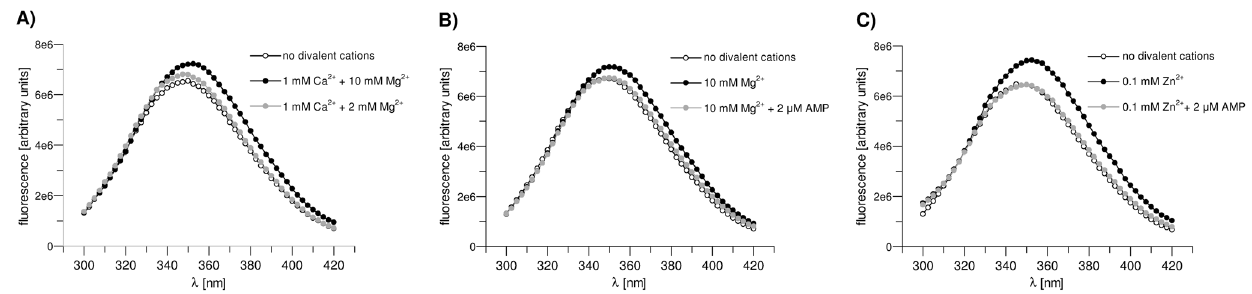
Figure 2. Fluorescence spectra of the Tyr 57 Trp mutant under different ligation conditions. A) Enzyme under R-state conditions of ligation (5 mM F6P and 5 mM KPi) in the presence of various concentration of Ca 2 + and Mg 2 + . B) Enzyme under R-state conditions of ligation (5 mM F6P and 5 mM KPi) in the presence of various concentration of Mg 2 + and under T-state conditions of ligation (5 mM F6P, 5 mM KPi, and 2 m M AMP) in the presence of Mg 2 + . C) Enzyme under R-state conditions of ligation (5 mM F6P and 5 mM KPi) in the presence of various concentration of Zn 2 + and under T-state conditions of ligation (5 mM F6P, 5 mM KPi, and 2 m M AMP) in the presence of Zn 2 + . The final emission spectra do not depend on the sequence of the ligands addition.